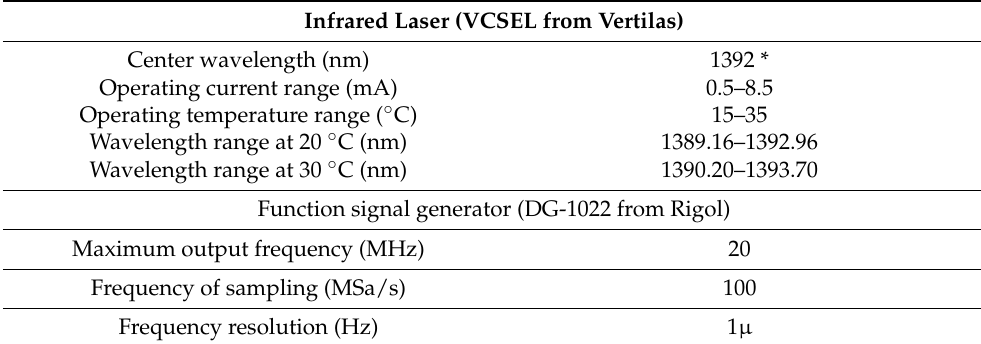
Table 1. Main parameters of laser and function signal generator